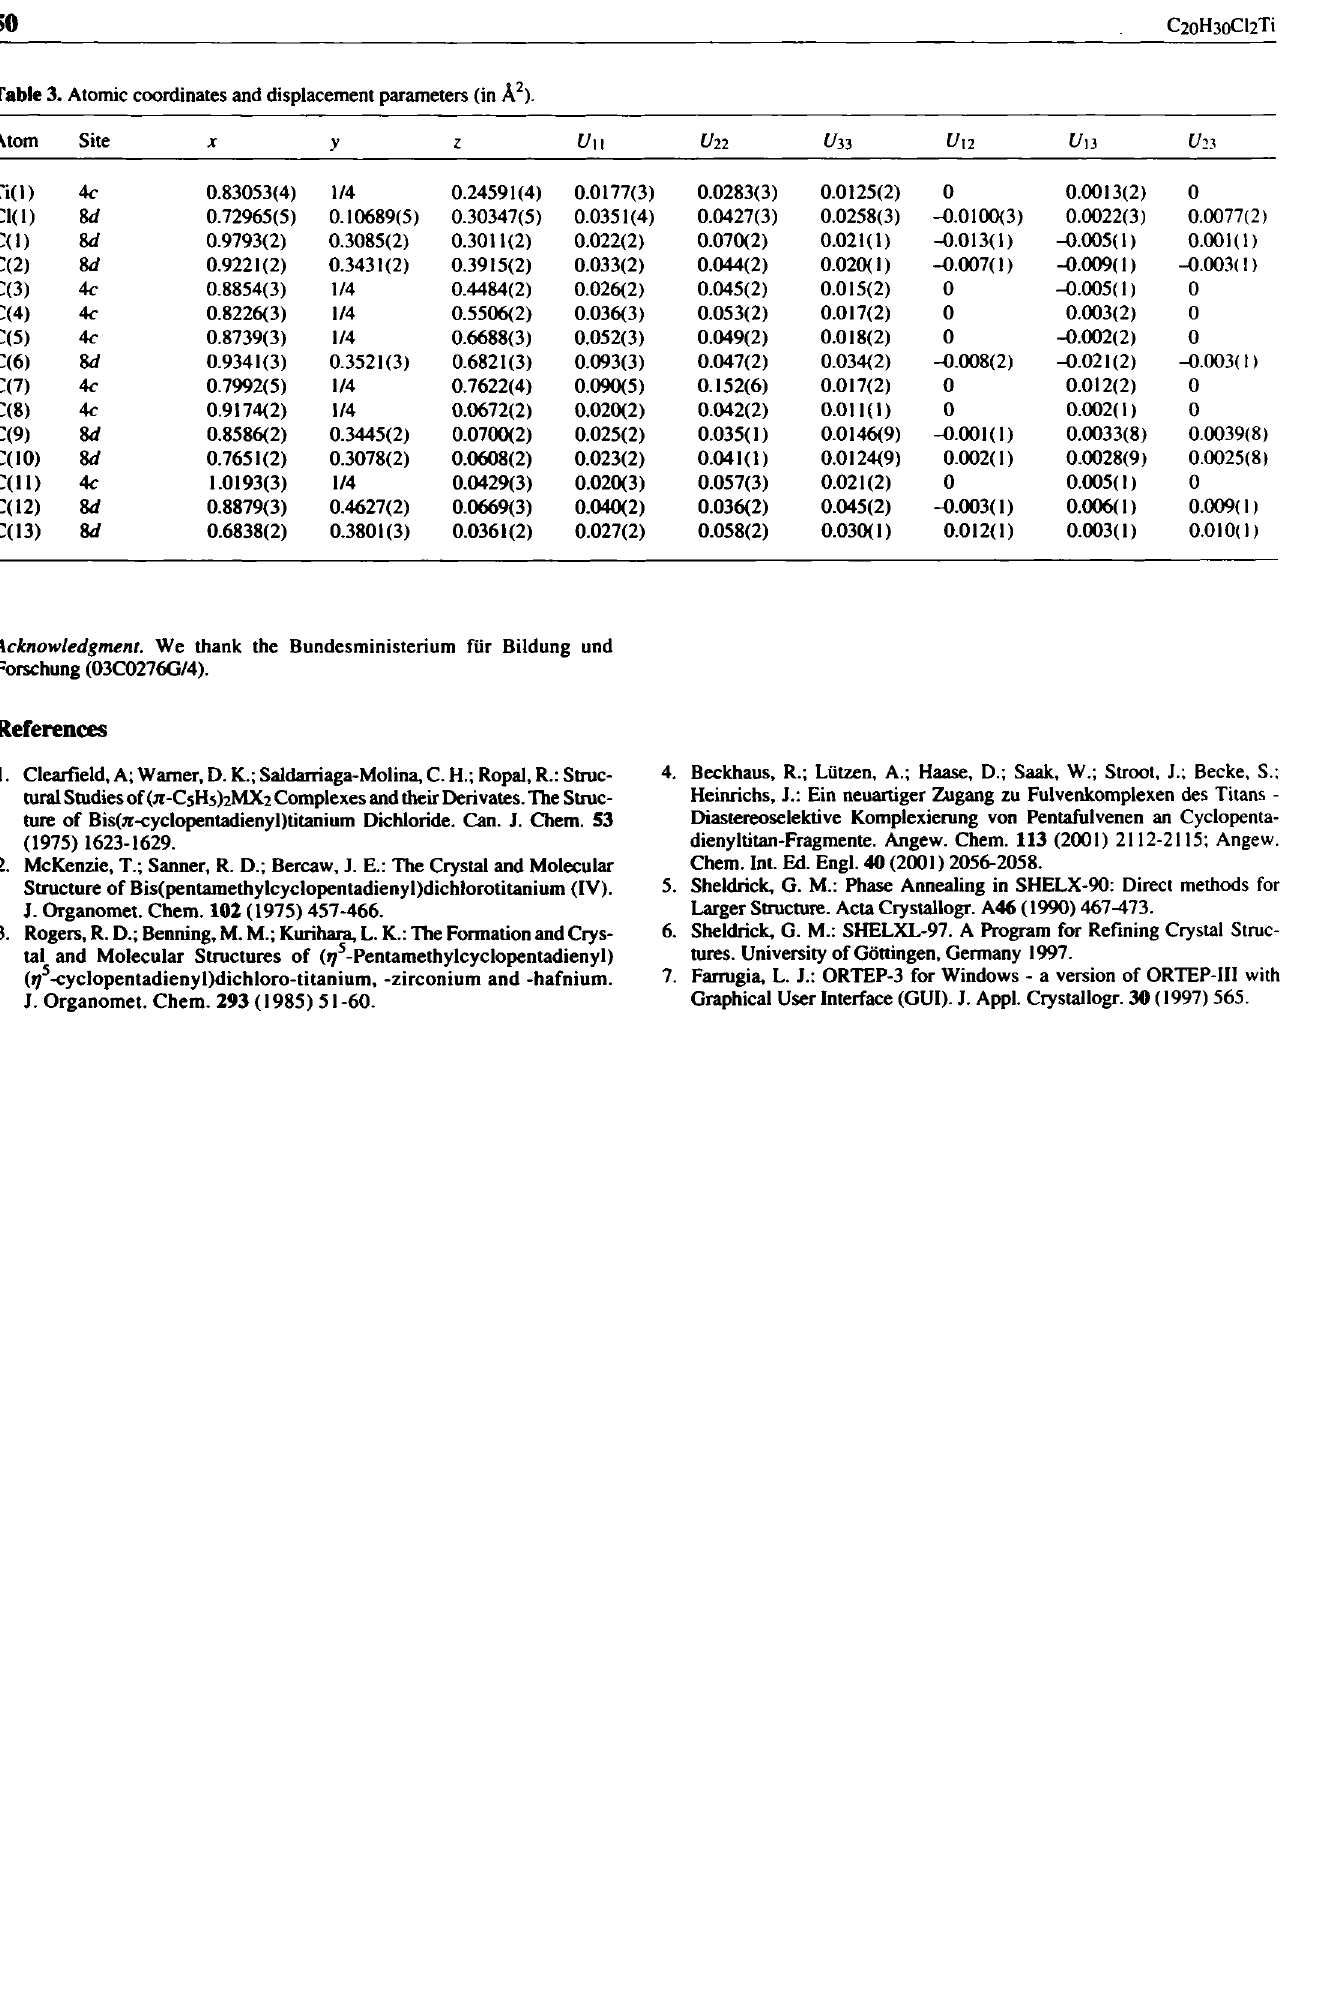
Table 3. Atomic coordinates and displacement parameters (in À 2